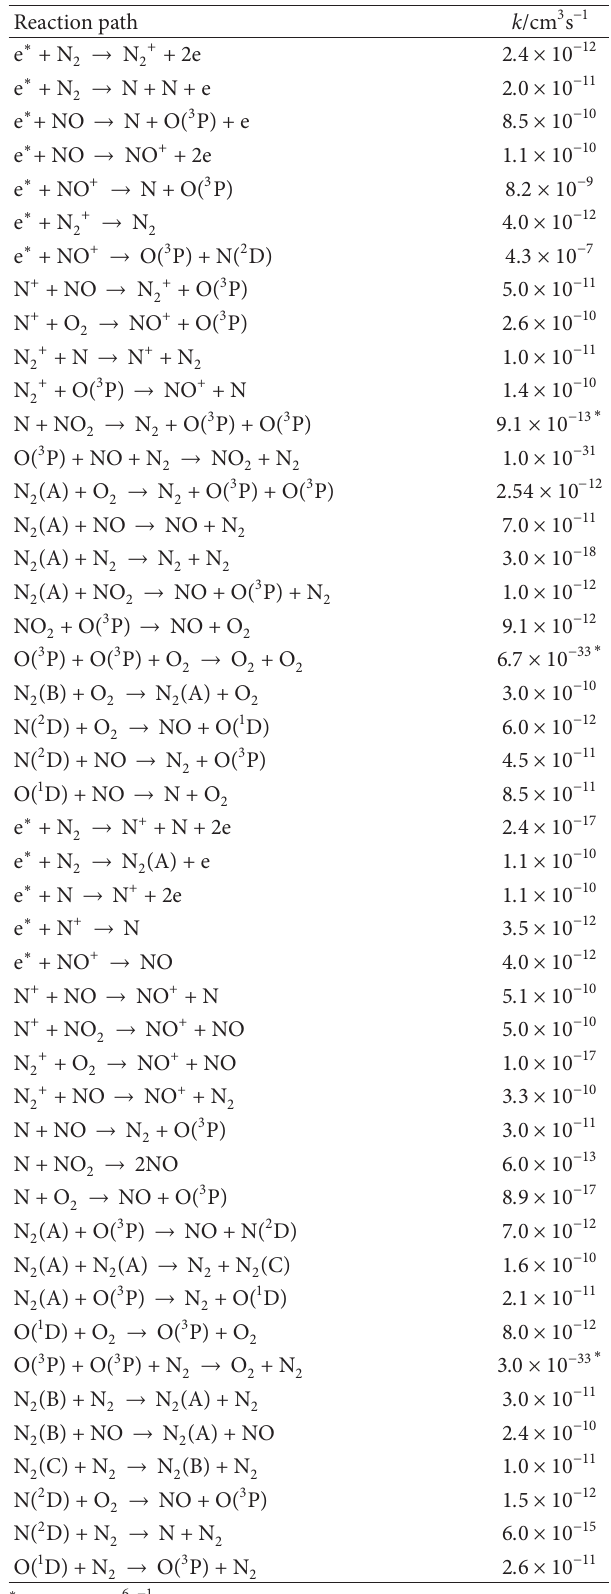
Table 3: Reaction paths and the corresponding reaction rate coefficients